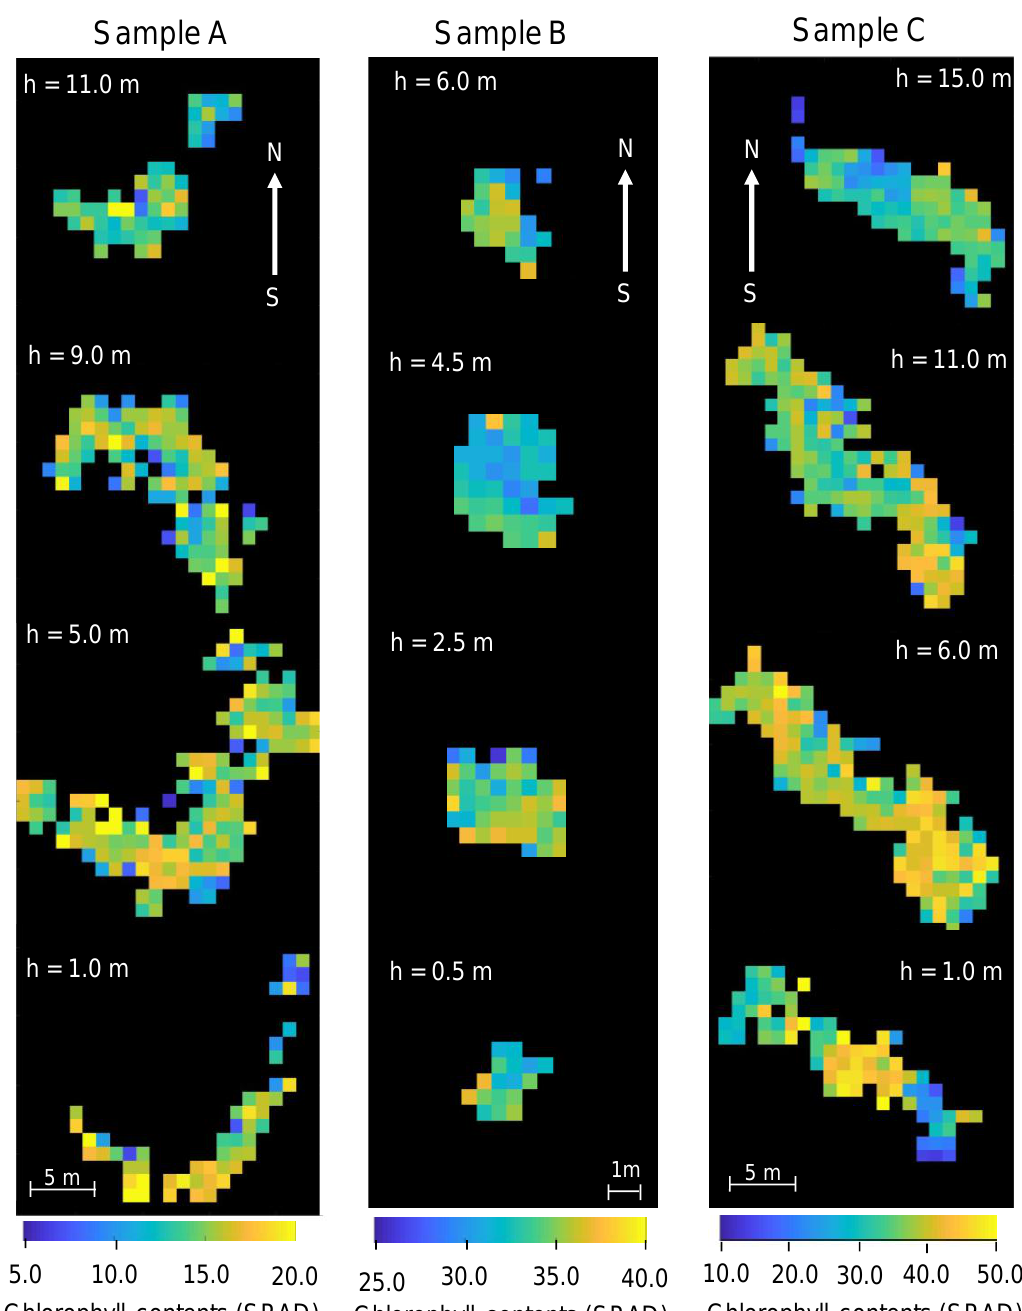
Figure 6. Horizontal distribution of Chl contents in each horizontal layer. h = height of the layer.